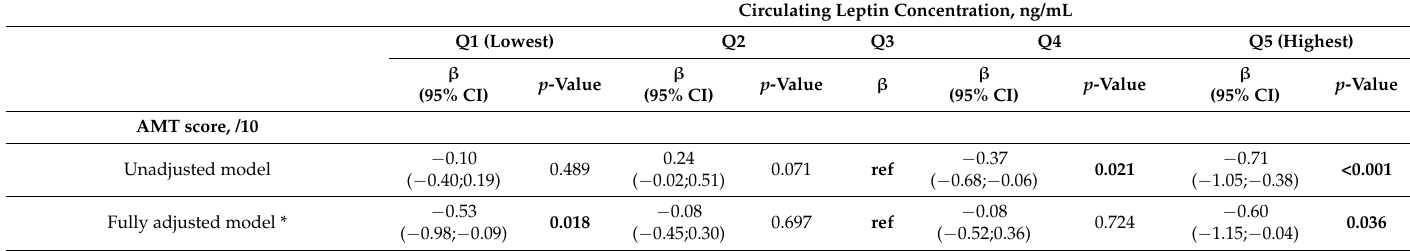
Table 2. Univariate and multiple linear regressions showing the cross-sectional association between the quintiles of circulating leptin concentration (independent variable) and the Abbreviated Mental Test (AMT) score and subscores (dependent variable), adjusted for participants’ characteristics * ( n =